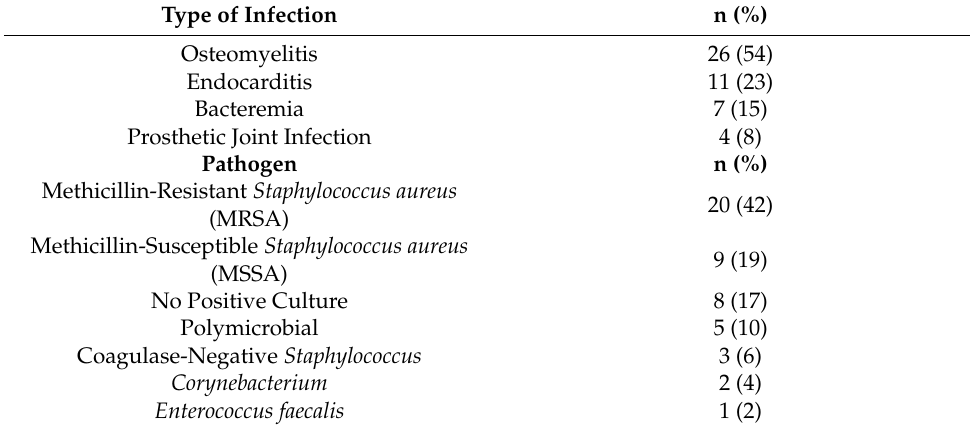
Table 2. Infection Characteristics (N =